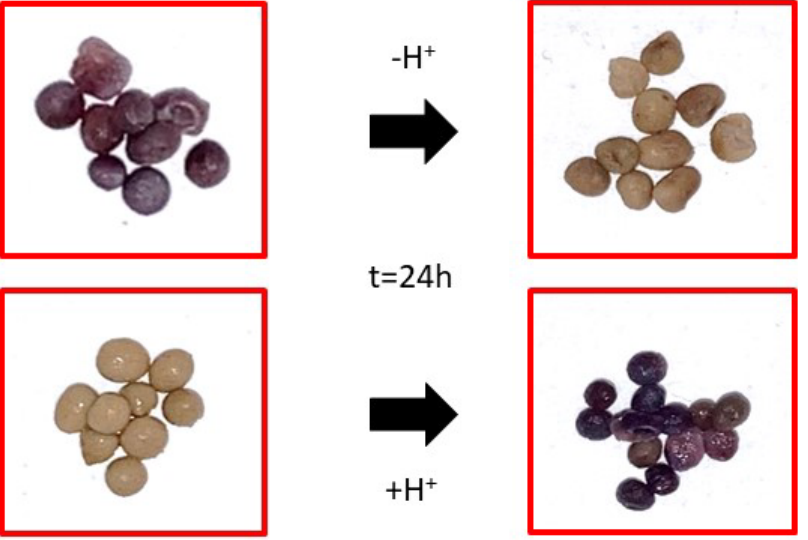
Figure 9. Reversibility of Lambrusco anthocyanin-encapsulated beads.